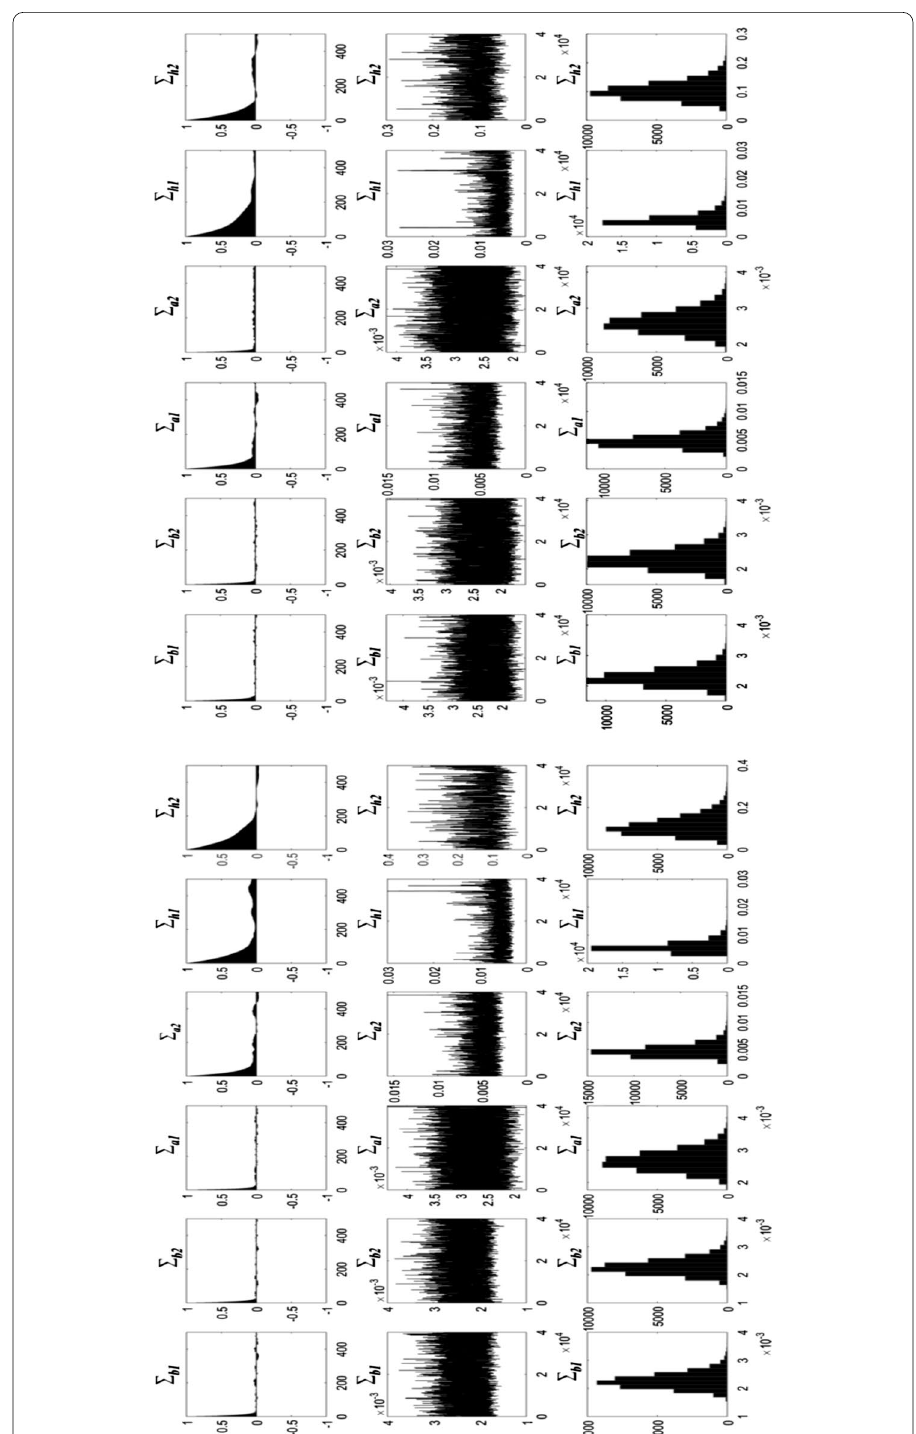
Fig. 9 MCMC samples of the TVP-VAR-SV parameters. Left: Parameters of TVP-VAR-SV with the ordering { EPU , NEF , R } . Right: Parameters of TVP-VAR-SV with the ordering { EPU , R , NEF } . Sample autocorrelations (top), sample paths (middle) and posterior histograms (bottom). The estimates of � β and (cid:31) a are multiplied by 100. The TVP-VAR-SV models are estimated using one